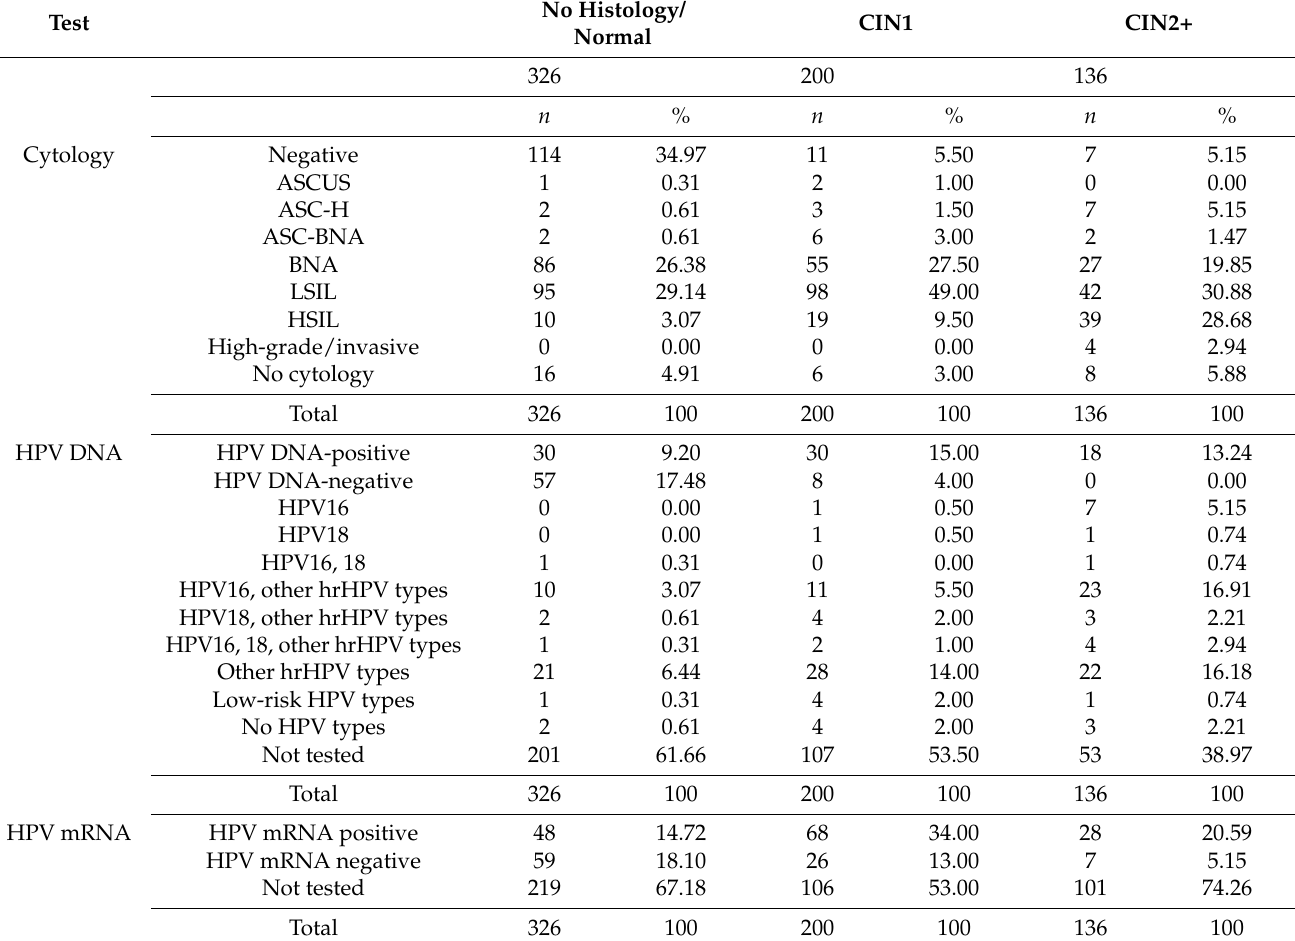
Table 1. Summary of training set of samples, including cytology, HPV DNA and HPV mRNA